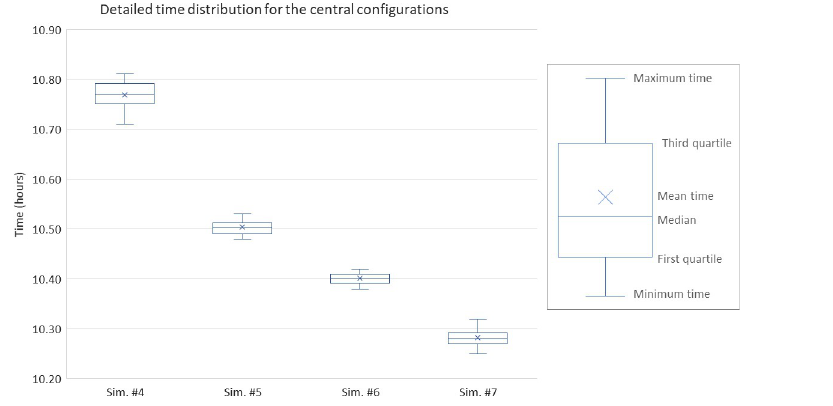
Fig 6. Detailed box and whisker chart for key configurations (Sim. #4 to Sim. #7).